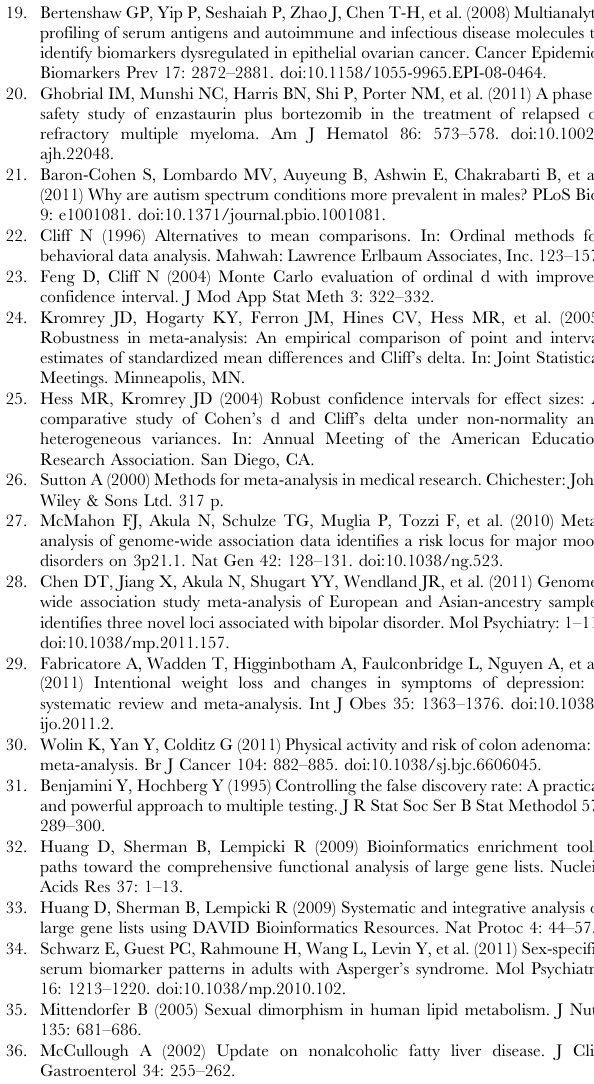
Table S1 Clusters of molecules. Assignment of all molecules in cohort 7 using k-means